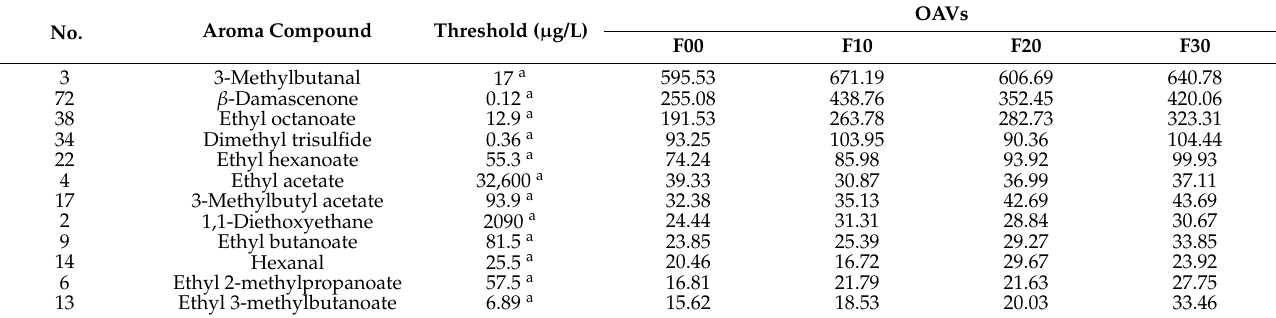
Table 3. The odor activity values (OAVs) of aroma compounds in four different grades of